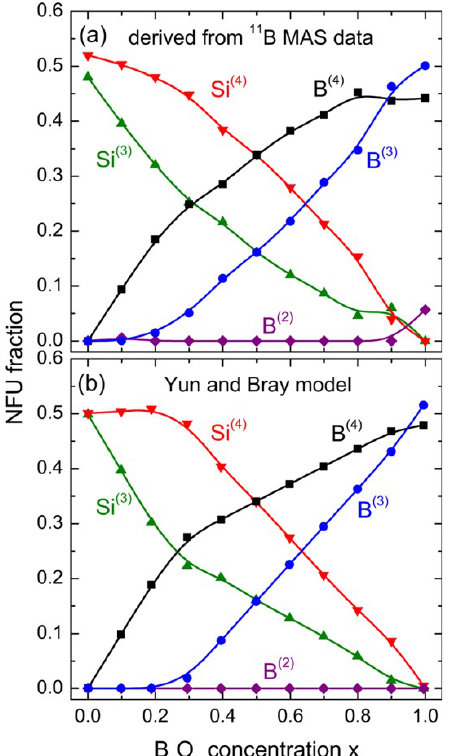
Figure 7. Network forming unit (NFU) fractions of sodium borosilicate glasses as determined ( a ) by 11 B NMR, and ( b ) by the Yun and Bray model [21] .